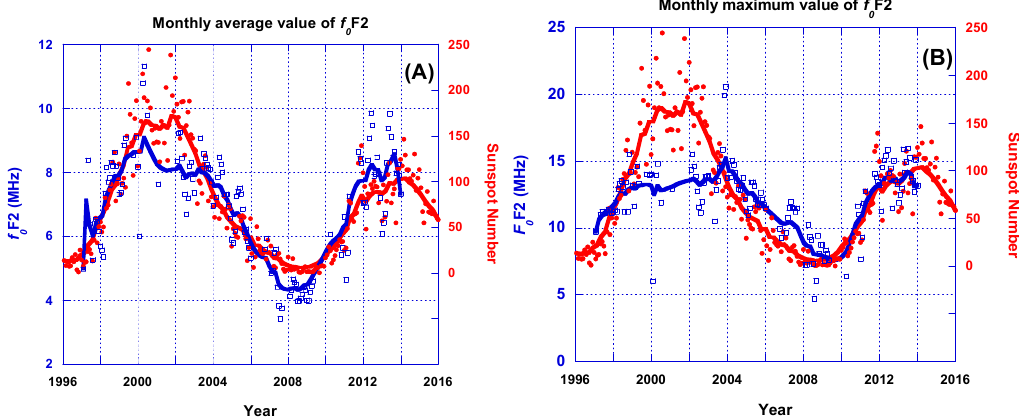
Figure 1. The time series of the monthly average ( A ) and the monthly maximum ( B ) values of ionospheric critical frequency f 0 F2 (in MHz). The two plots are compared with the monthly average sunspot number, SSN showing a good agreement. The blue color of the left axis values, smooth curve and square points refer to f 0 F2 values, while the red color of the right axis values, smooth curve and round points denote to the sunspot numbers.